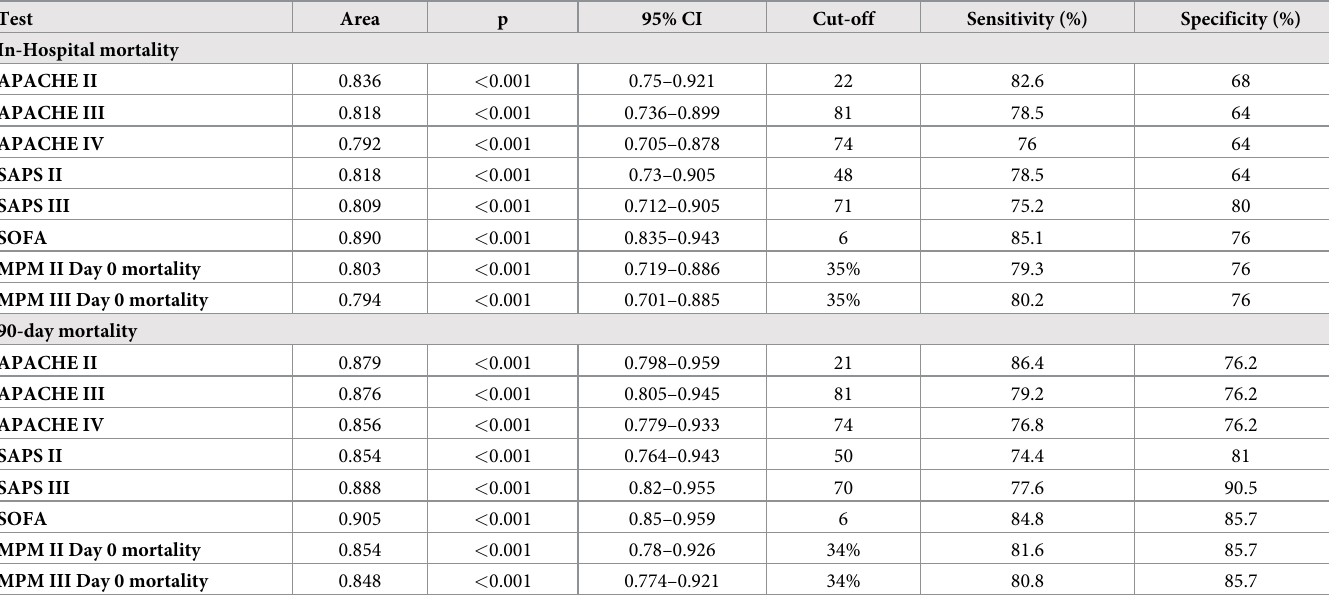
Table 2. ROC curve comparison between the different prognostic